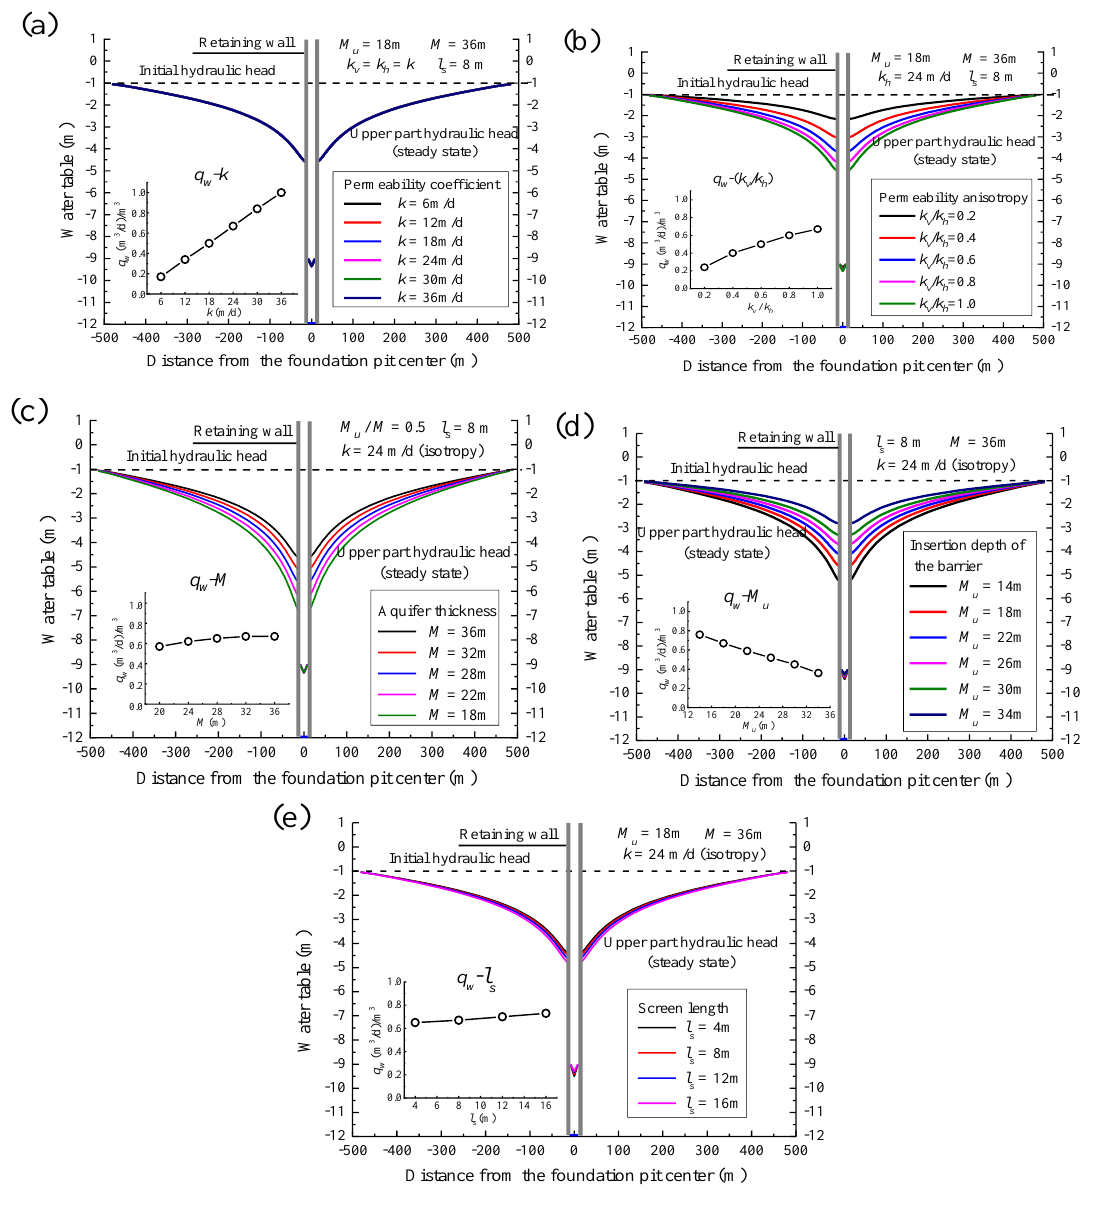
Figure 5. Water table on the central cross-section with variation dewatering parameters: ( a ) Permeability; ( b ) permeability anisotropy; ( c ) aquifer thickness; ( d ) insertion depth of barriers; ( e ) screen length of pumping well.